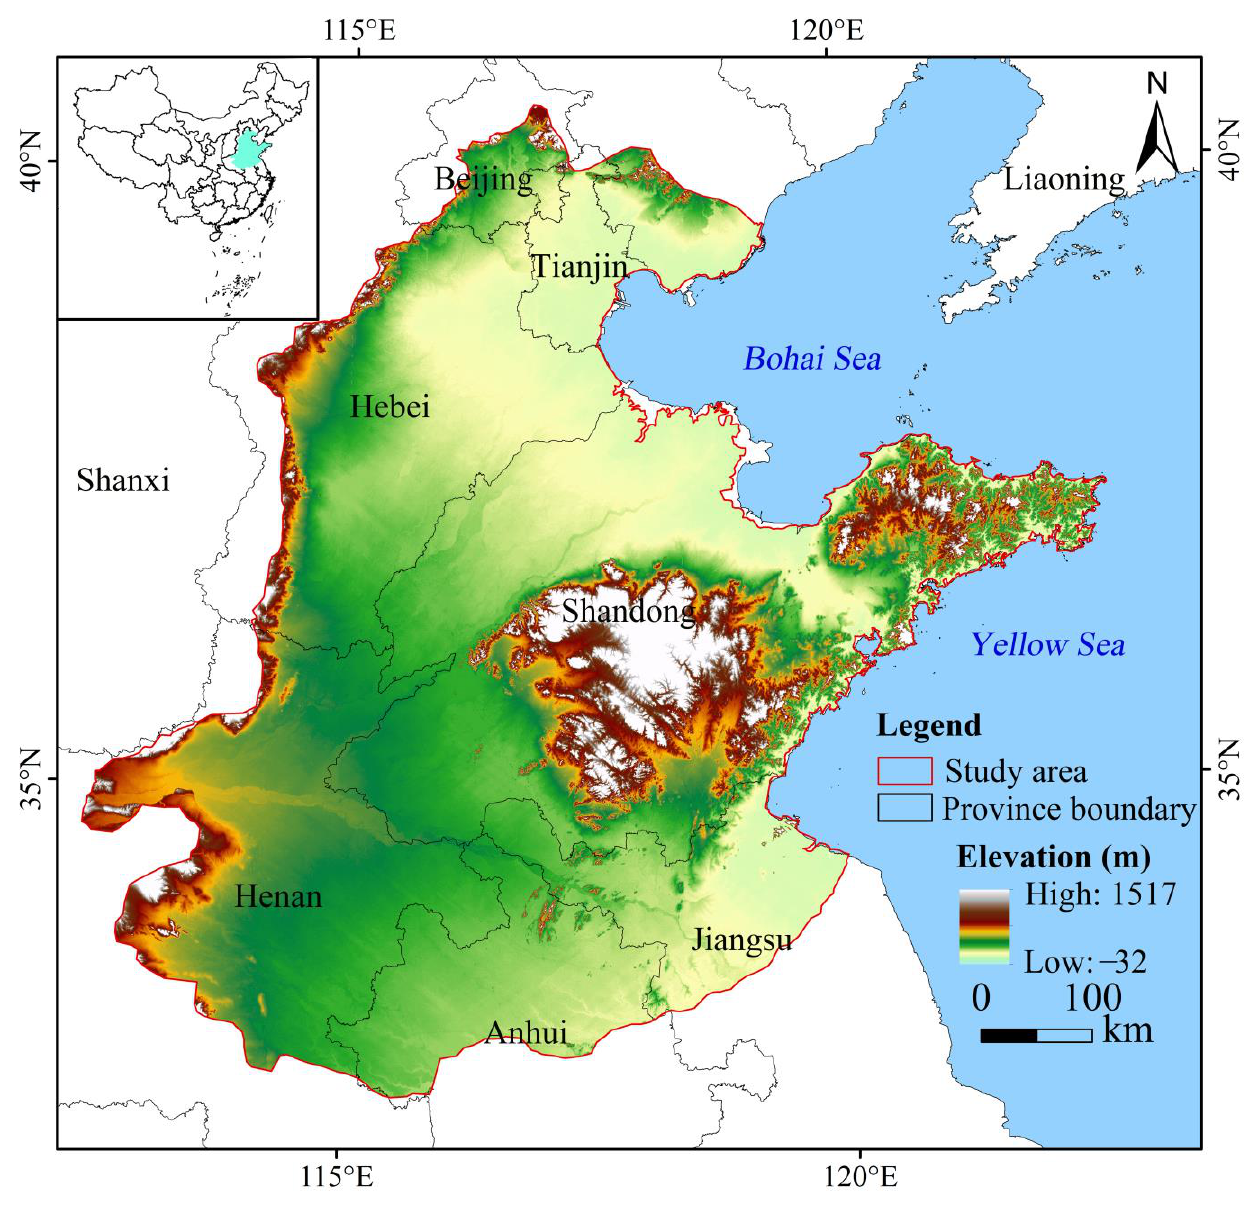
Figure 1. Location of the study area.